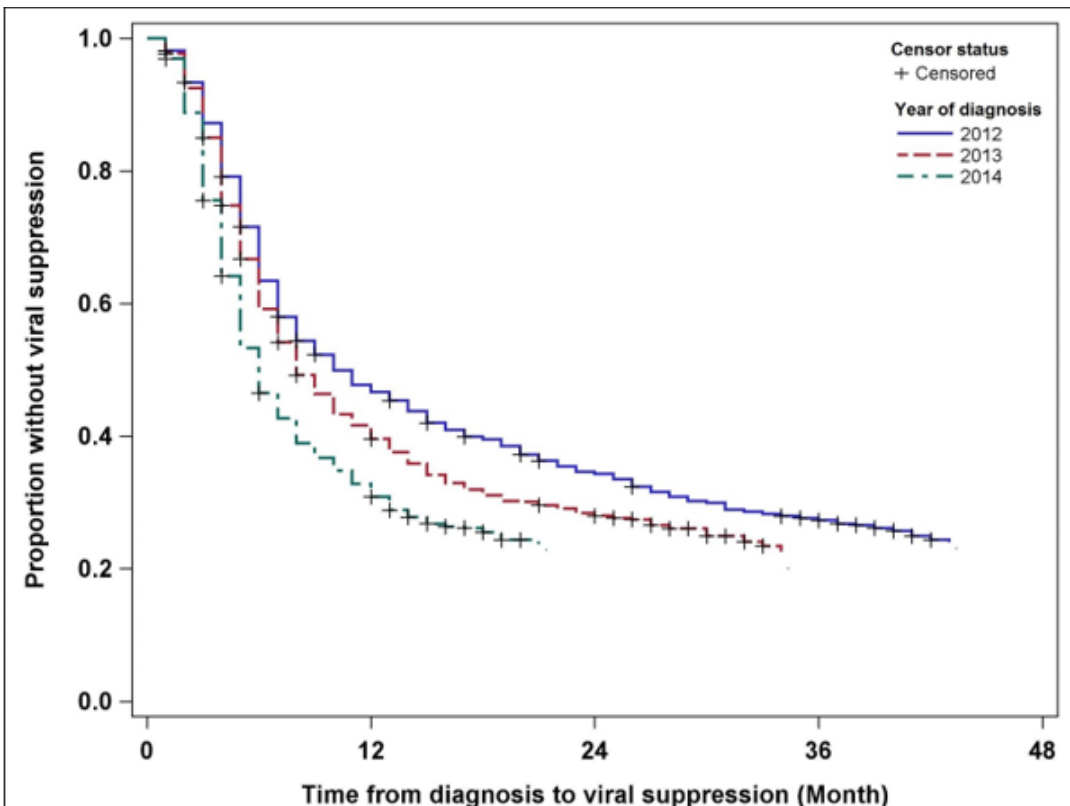
Figure 2. Kaplan-Meier plots of time from HIV diagnosis date to reported first viral suppression (VS, <200 c/mL) among 1979 persons with newly diagnosed HIV ≥ 13-years-old in Alabama, 2012-2014, stratified by year of